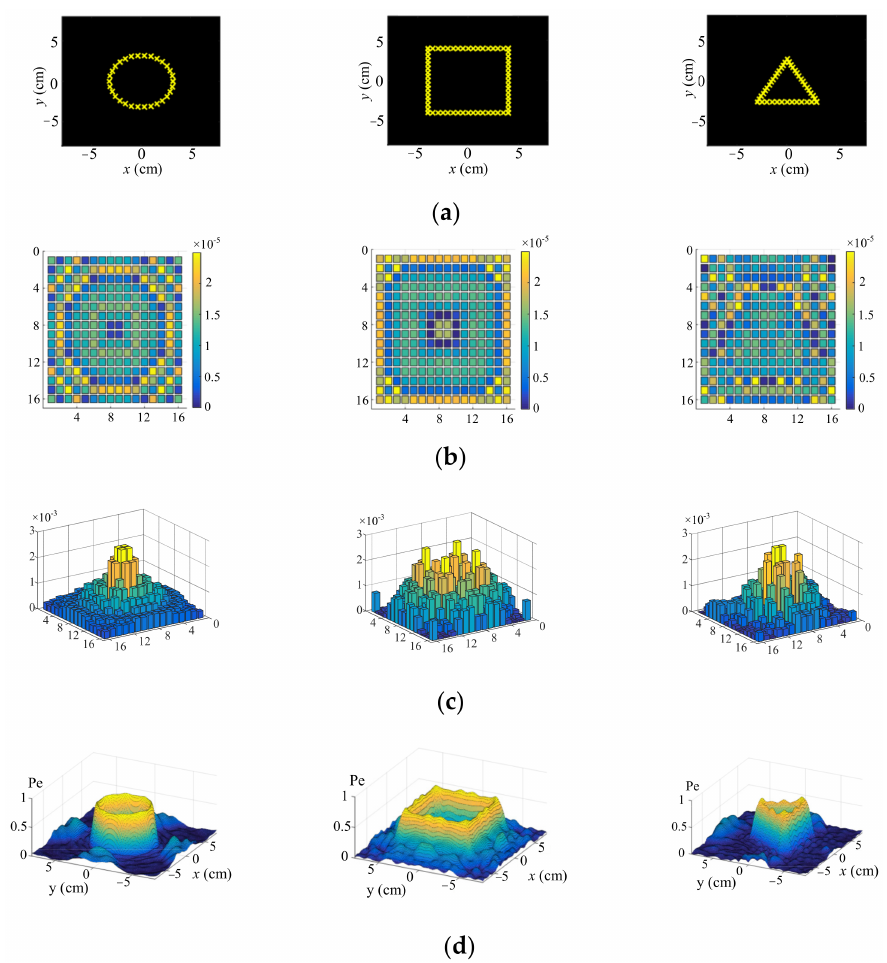
Figure 4. Simulation for complex geometries. ( a ) is the desired focal geometries arranged in the forms of circle, rectangle and triangle, respectively. ( b – d ) present the corresponding phase difference distribution, amplitude distribution and ultrasound pressure distribution,